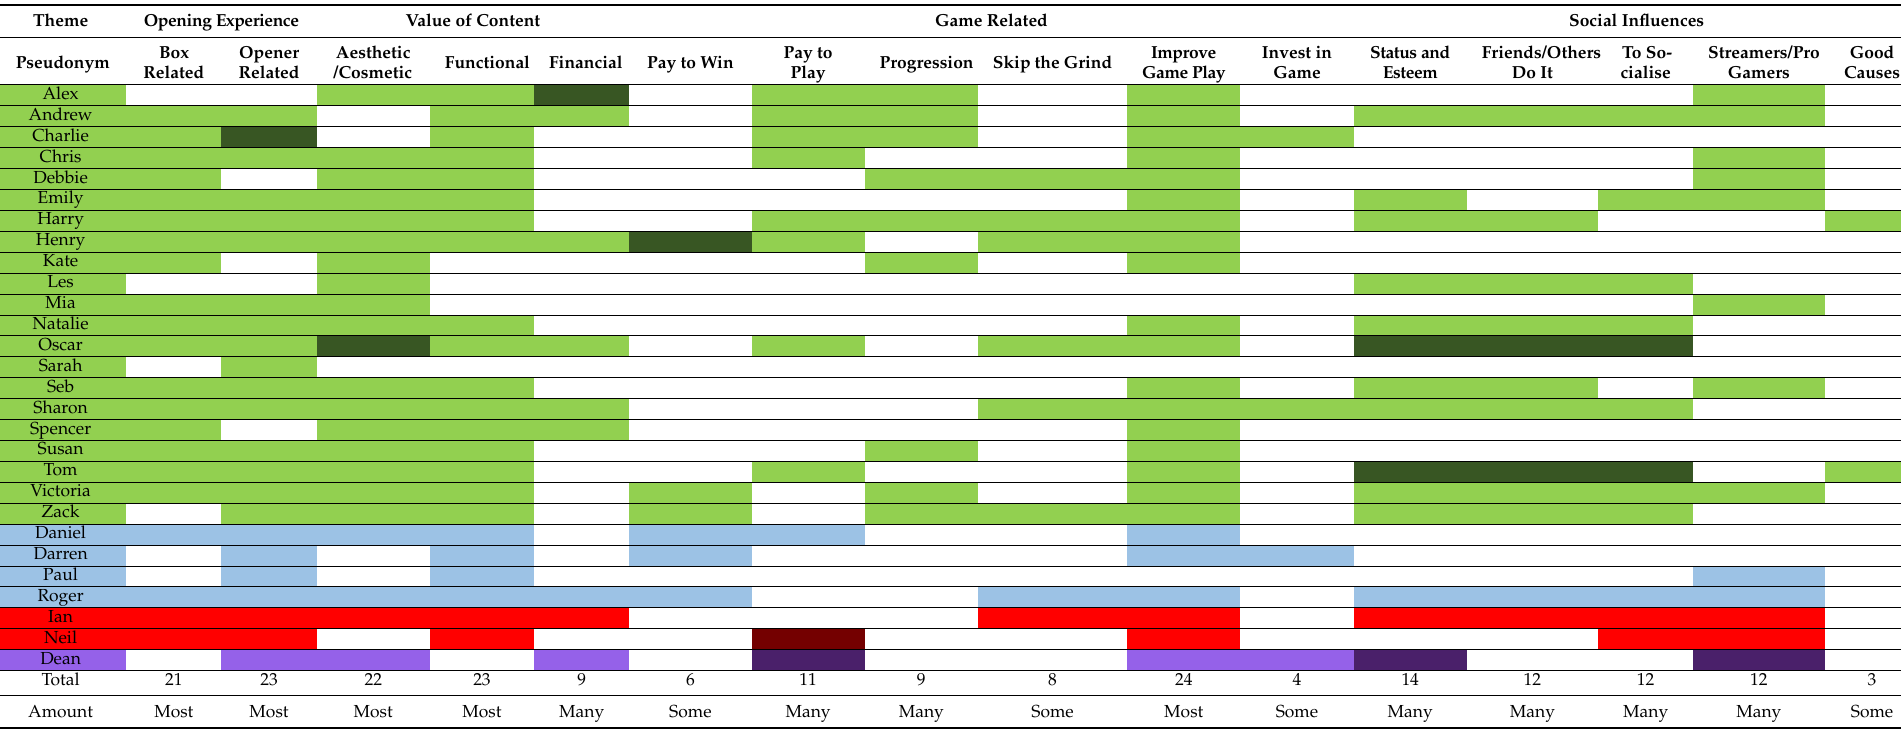
Table 3. Distribution of themes across the sample for opening experience, value of content, game related and social